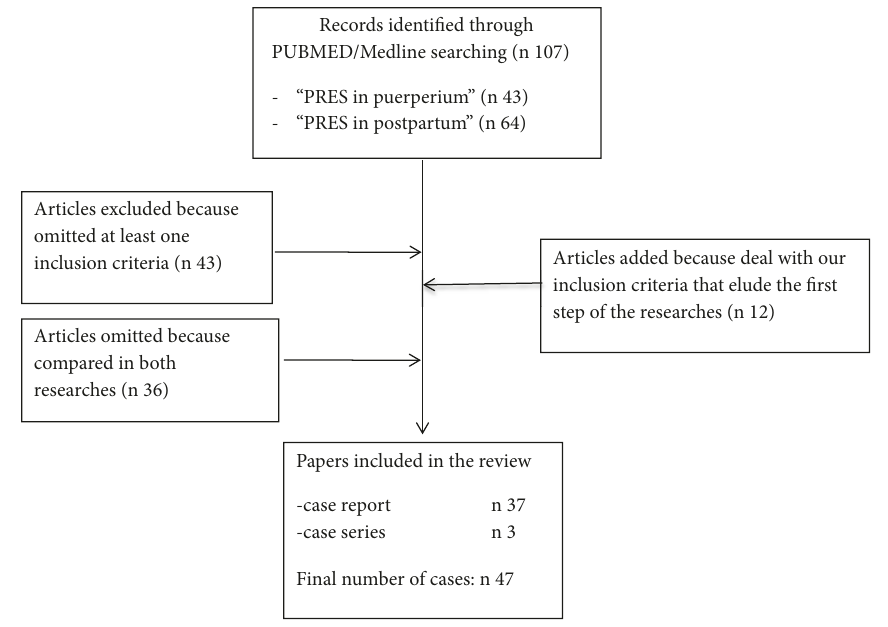
Figure 3: PRISMA 2009 flow